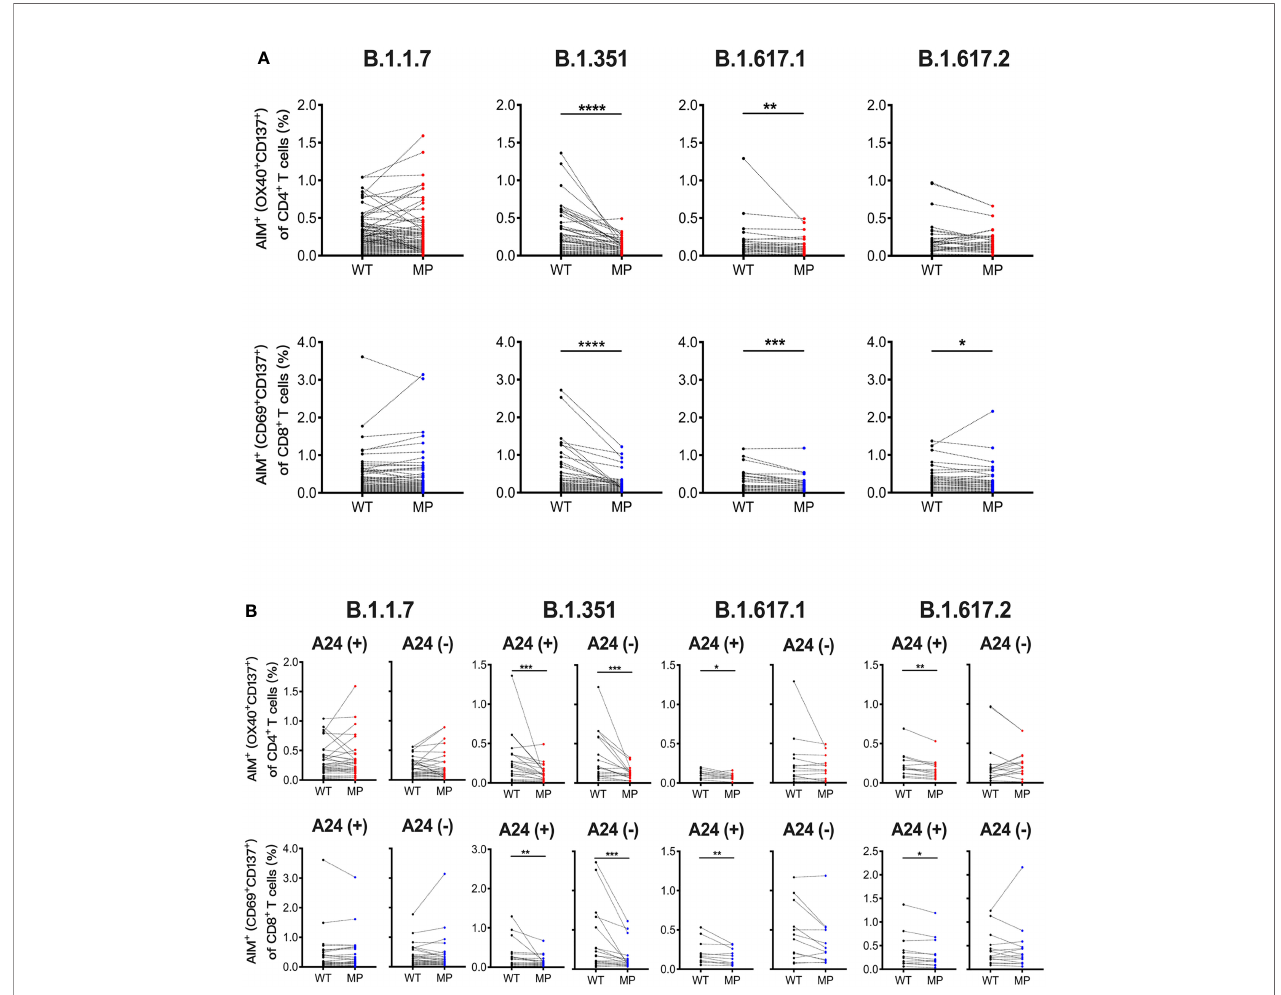
FIGURE 2 | SARS-CoV-2 mRNA vaccination-induced T cell responses against SARS-CoV-2 variants. Peripheral blood mononuclear cells from individuals at 1 month post-vaccination were stimulated for 22 hours with peptide pools that covered the mutated regions (MP) of SARS-CoV-2 and the corresponding wild-type control pools (WT). (A) The percentages of AIM + (OX40 + CD137 + ) CD4 + T cells and AIM + (CD69 + CD137 + ) CD8 + T cells responding to mutated spike pools (MP) of B.1.1.7 (alpha), B.1.351 (beta), B.1.617.1 (kappa), and B.1.617.2 (delta) as well as each control pool (WT) are shown. (B) The percentages of AIM + (CD69 + CD137 + ) CD8 + T and AIM + (OX40 + CD137 + ) CD4 + T cells responding to the indicated MP and WT in HLA-A24-positive and -negative individuals are shown. *p < 0.05, **p < 0.01, ***p < 0.001, ****p < 0.0001 (Wilcoxon matched-pairs signed-rank